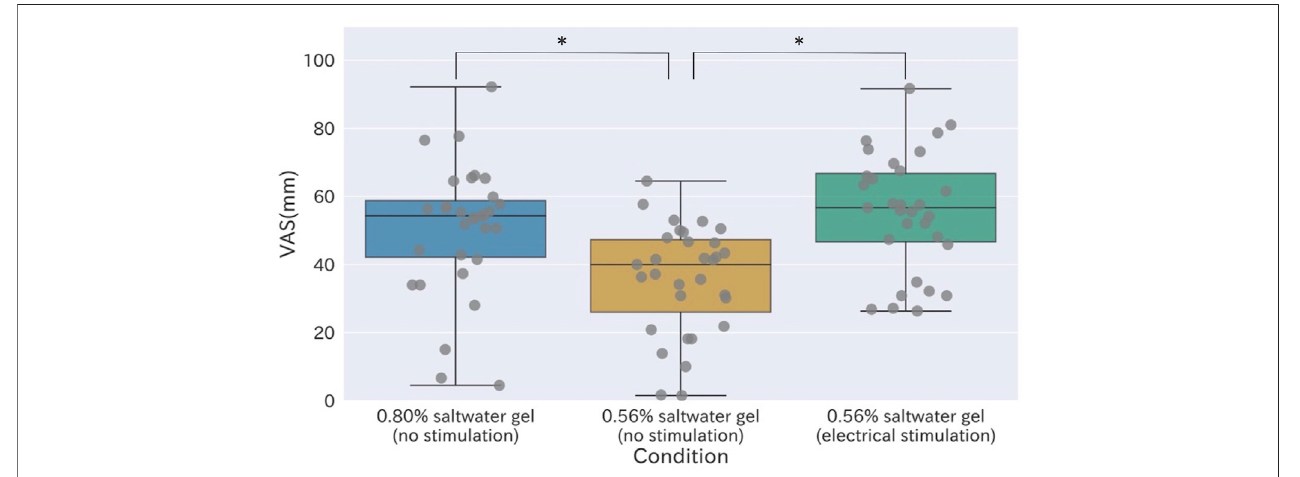
FIGURE 10 | Evaluation results of saltiness intensity in Experiment 1 (* indicates p < 0.05). The one-dimensional scatterplot shows the mean value for each participant.